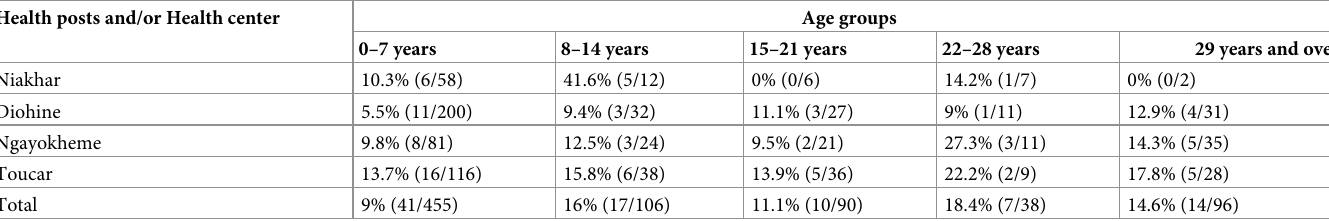
Table 2. Prevalence of Borrelia infection by age group in the Niakhar district. Health posts and/or Health